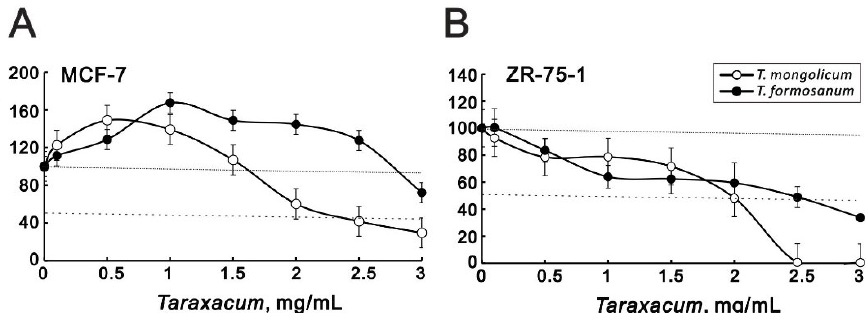
Figure 10. Cytotoxicity of T. mongolicum and T. formosanum toward MCF ‐ 7 and ZR ‐ 75 ‐ 1 cells. ( A ) MCF ‐ 7 and ( B ) ZR ‐ 75 ‐ 1 cells were treated for 72 h with the indicated concentrations of T. mongolicum or T. formosanum . Cell viability was measured using MTT assays, and ( B ) cell morphology was observed using light microscopy. The results are representative of three independent experiments. Symbols depict the mean ±SD.